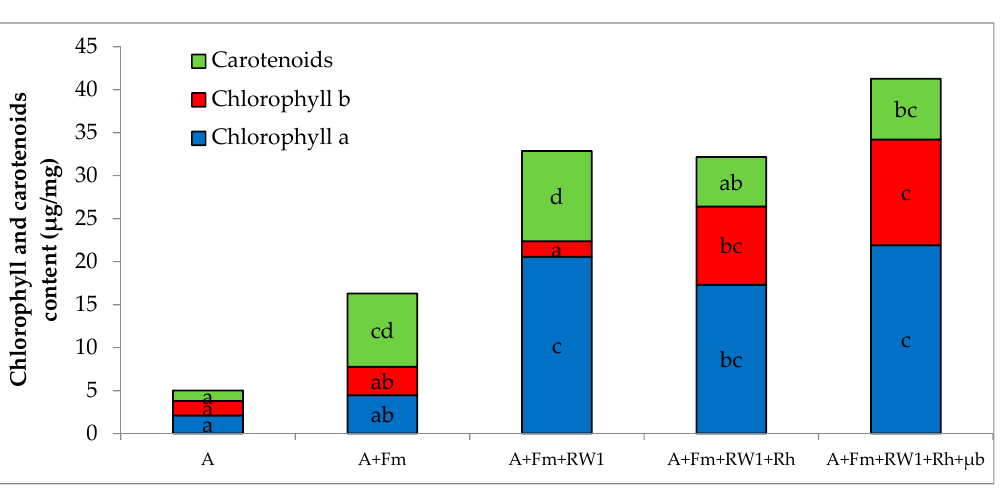
Figure 1. Chlorophyll a and b and carotenoids content in leaves of non-inoculated alfalfa (A), combined with F. mosseae (A + Fm), plus S. wittichii RW1 (A + Fm + RW1), plus rhamnolipids Rh (A + Fm + RW1 + Rh), plus microbiota µ b (A + Fm + RW1 + Rh + µ b) grown in microcosms for six months on the aged polluted soil. Di ff erent letters indicate significant di ff erences between conditions according to the Kruskal–Wallis test ( p ≤ 0.05). Values are means ± s.d. ( n = 5).